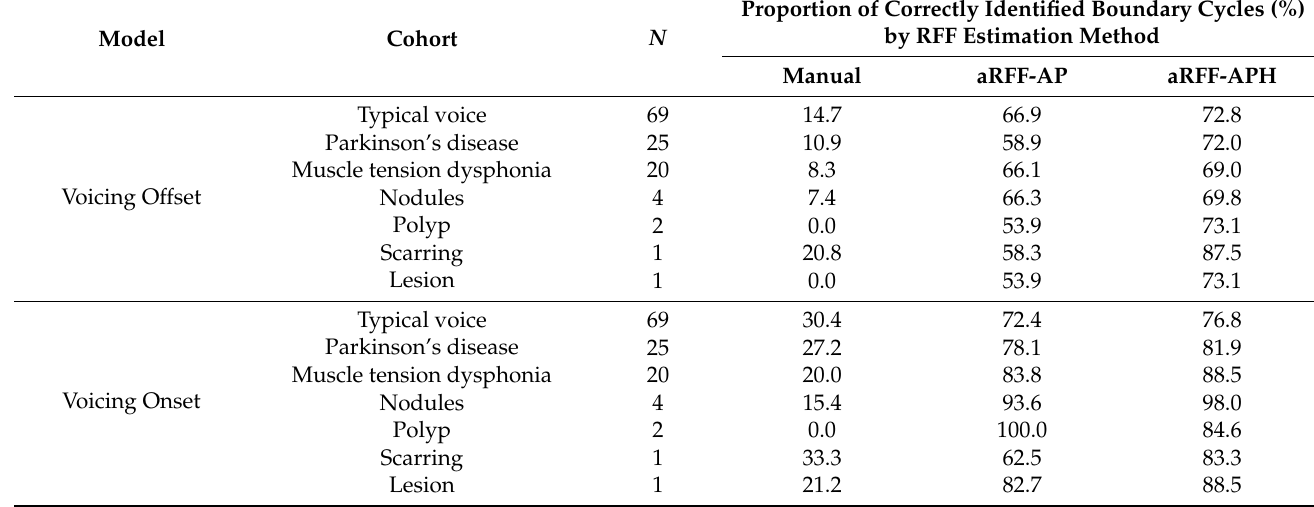
Table 5. Proportion of correctly identified boundary cycles (%) by RFF estimation method and cohort.